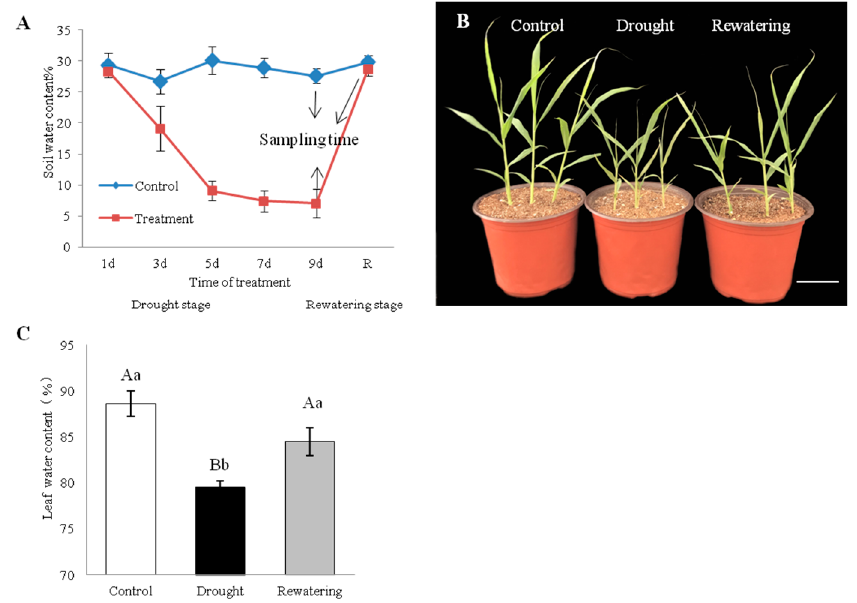
Figure 1. E ff ects of drought stress and re-watering on foxtail millet, variety Jigu 16. ( A ) Soil volumetric water content during the 9-day drought and 12-h re-watering treatments. Arrows indicate the time points when plants were sampled for RNA-seq. Each column represents the mean ± SD ( n = 3). ( B ) Phenotypic alterations of foxtail millet seedlings under control conditions and after 9 days of drought stress and 12 h of re-watering. Bar = 5 cm. ( C ) Changes in leaf water content under 9-day drought and 12-h re-watering conditions. Each column represents the mean ± SD ( n = 3 pools of x plants). Significance levels were determined by one-way ANOVA; Di ff erent letters above bars indicate significant di ff erences, lowercase letter p < 0.05, uppercase letter p <